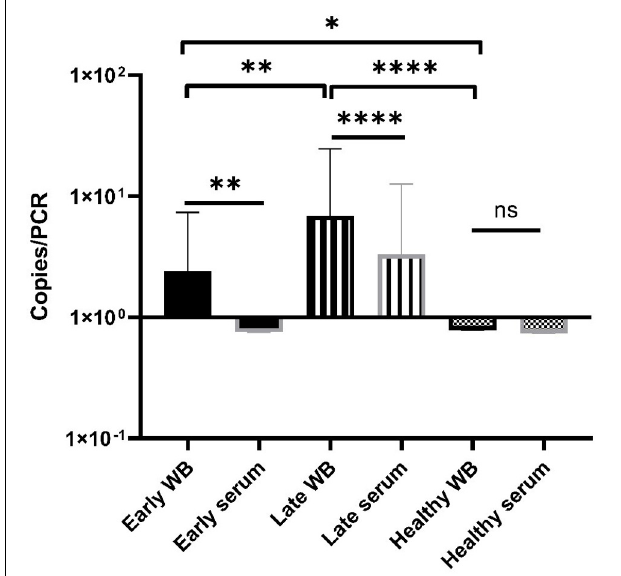
FIGURE 7 | Bar graph displaying the mean terL levels (with SD values) of the three respective study groups from whole blood (black border) and serum (gray border) samples. The Mann-Whitney U test was used to compare differences between early LD patients, late LD patients, and healthy volunteers. The terL copy numbers obtained from the blood samples of late LD patients are significantly higher larger than those of the early LD patients and healthy volunteers, while the terL copy numbers of early LD patients are significantly higher larger than those of healthy volunteers. Statistical significance is denoted as ns ( p > 0.05), * ( p < 0.05), ** ( P < 0.01), *** ( P < 0.001), and **** ( P <